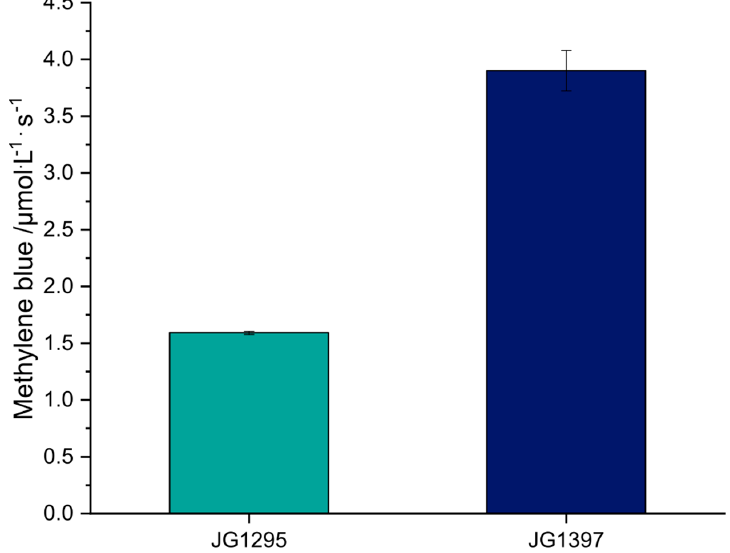
Figure A3. Reduction rates with 273 µmol/L methylene blue for JG1295 and JG1397 in a cell suspension of OD 600 = 6.